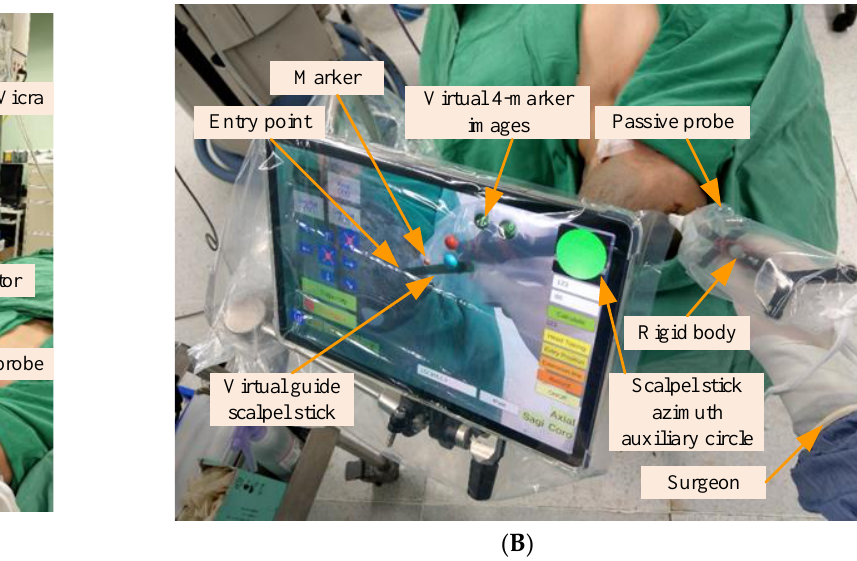
Figure 8. Clinical system architecture and tablet close-up. ( A ) Overall structure. ( B ) Tablet close-up.